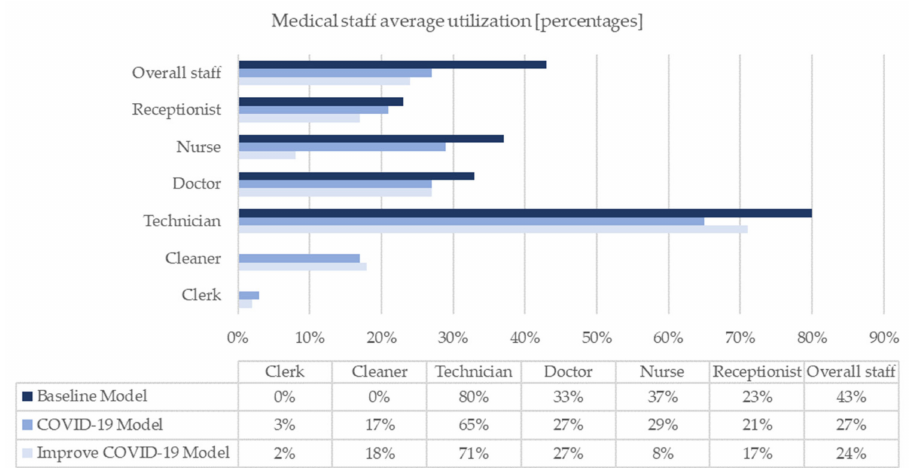
Figure 8. Medical staff average